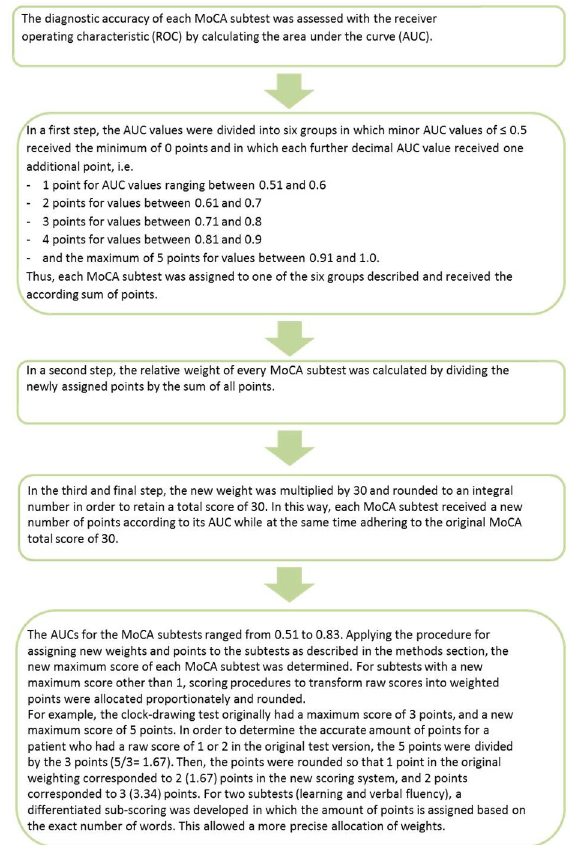
Fig 1. Presentation of the development of the new MoCA